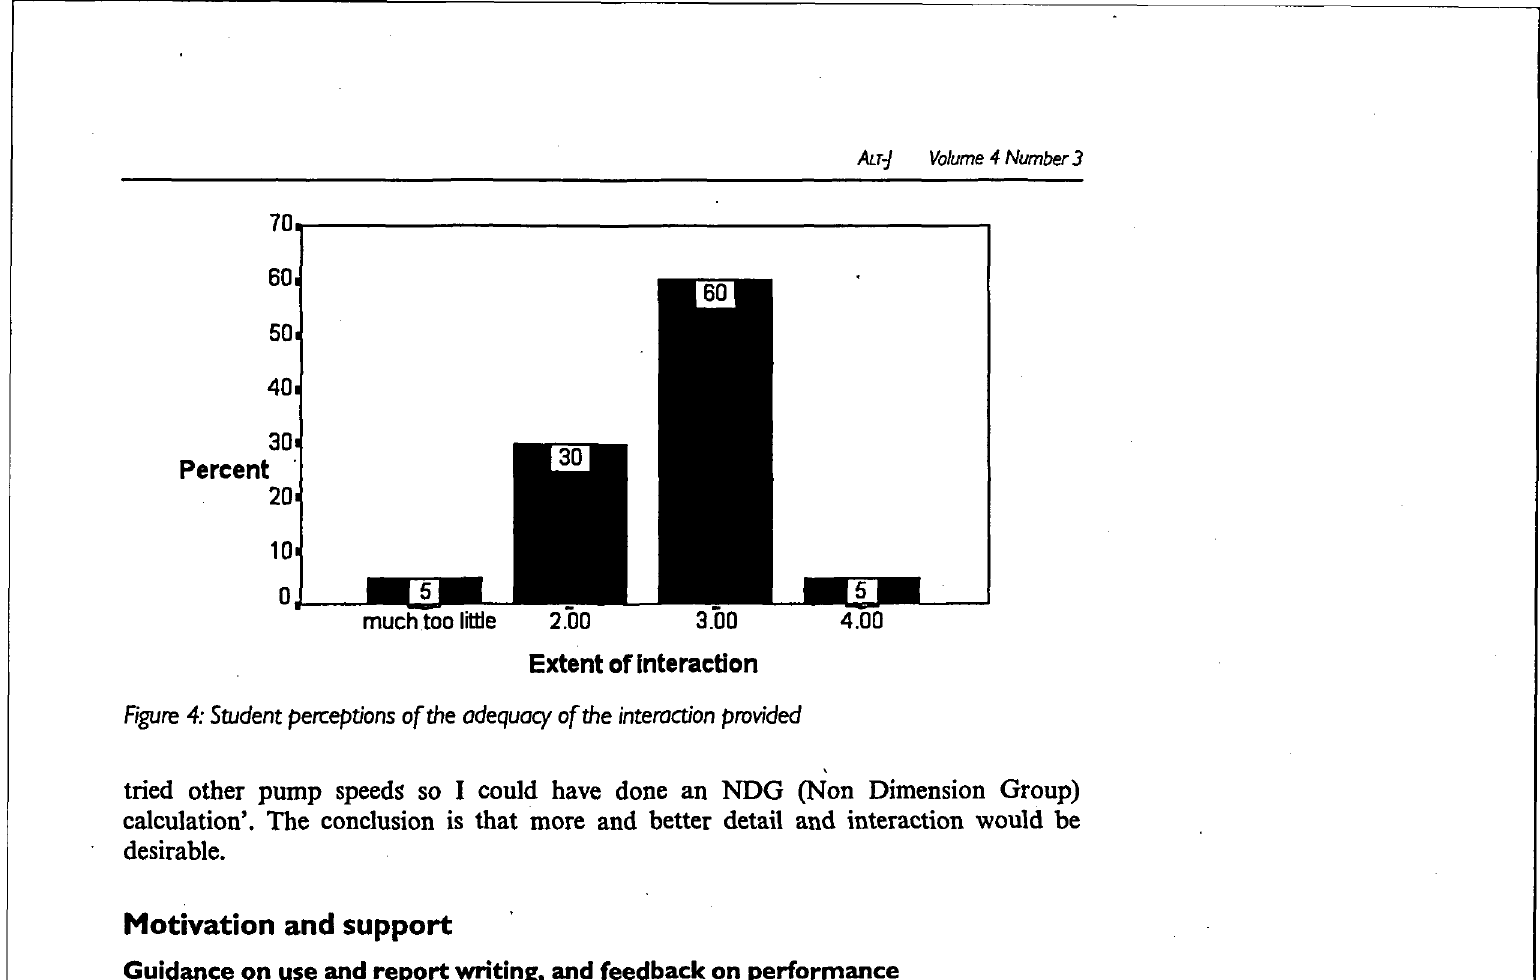
Figure 4: Student perceptions of the adequacy of the interaction provided